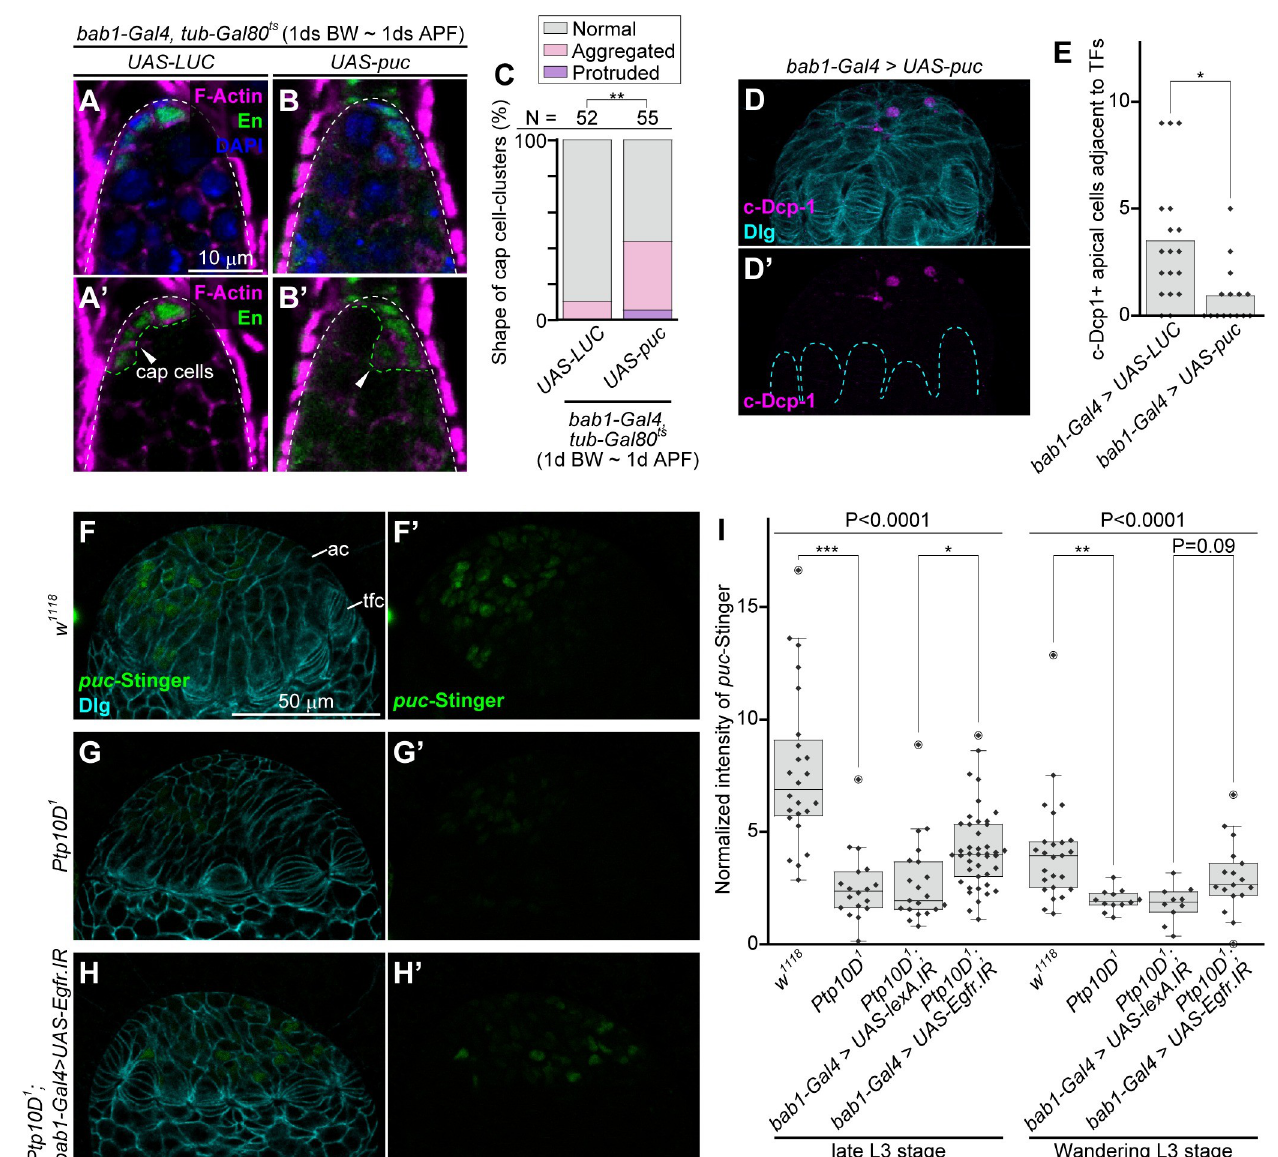
Fig 5. Ptp10D 1 causes the reduction of JNK signaling activity in the apical cells. (A and B) Germaria of indicated genotypes (upper) 2 days after eclosion that are treated with the temperature-sift (29˚C, 1d BW ~ 1d APF) are shown. Germaria with dish-like (A) and abnormal (B) cap cell-clusters are shown as examples. (A’ and B’) Magenta/green channels of (A and B). White dashed lines in (A, A’, B, and B’) and green dashed line with arrowheads in (A’ and B’) indicate outlines of germaria and cap cell-clusters, respectively. Scale bar in (A) is 10 μ m, and applicable for (A’, B and B’). (C) 100%-stacked bar graph represents % of germaria with normal (gray), aggregated (pink), and protruded (purple) cap cell-clusters in indicated genotypes. LUC (use same data value in Fig 4C, lane 3) is used as a control. Numbers (N) of samples observed and P-value for Fisher’s exact test are shown at the upper. (D) Female gonad at wandering L3 stage (corresponding to the stage of S7D Fig) are labeled with anti-c-Dcp-1 antibody (magenta) and anti-Dlg antibody (cyan). The cell layer located at a opposite side of fat body-adherent surface is shown. Genotypes of samples are indicated at the upper. Images are processed by the Z-stack projection of two sections (corresponding to 3 μ m thickness) to visualize the boundary between terminal filament cells. (D) Magenta channels of (D). Scale bar in (D) is 50 μ m, and applicable for (D’). Cyan dashed lines in (D’) indicate boundary between apical cells (ac) and terminal filament cells (tfc). (E) Bar graph overlaid with beeswarm plots represent numbers (No.) of c-Dcp-1-positive apical cells adjacent to terminal filaments (TFs) per larval gonads in indicated genotypes. LUC was used as control. P-value ( * P < 0.01) for Mann-Whitney U test is shown at the upper. (F-H) Female gonads at late L3 stage (corresponding to the stage of S10C Fig) are labeled with puc -Stinger fluorescence (green) and anti-Dlg antibody (cyan). Genotypes of samples are indicated at the left. The cell layers located at a opposite side of fat body-adherent surface are shown. (F’-H’) Magenta channels of (F-H). Scale bar in (F) is 50 μ m, and applicable for (G, H, and F’-H’). (I) Boxplot overlaid with beeswarm plot represents normalized intensity of puc -Stinger in indicated genotypes. lexA . IR was used as a control. Data value from late L3 stage (corresponding to the stage of S6C Fig) and wandering L3 stage (corresponding to the stage of S6E Fig) are shown. P-values for Kruskal-Wallis rank sum test to four distributions (lane 1–4 and lane 5–8) are shown at the upper (line). P-values ( *** P < 0.0001, ** P < 0.001, * P < 0.01, 0.01 < “actual P-value” < 0.05) for Mann-Whitney U test with Bonferroni correction (post-hoc test) are